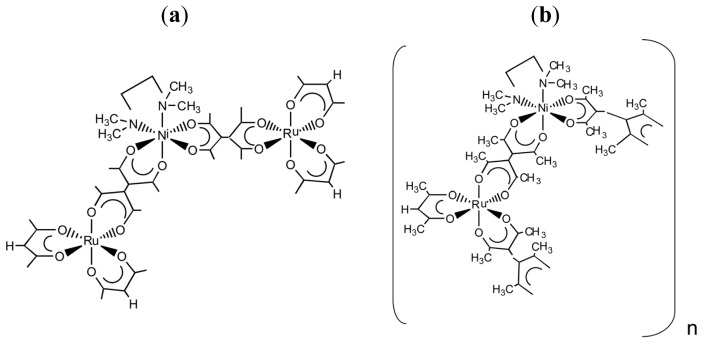
(a) [{Ru(III)(acac)2(taet)}2Ni(tmen)]; (b) [{Ru(III)(acac)(taet)2Ni(II)(tmen)} n{Ni(II)(tmen)}](ClO4)2 (modified from [19]).